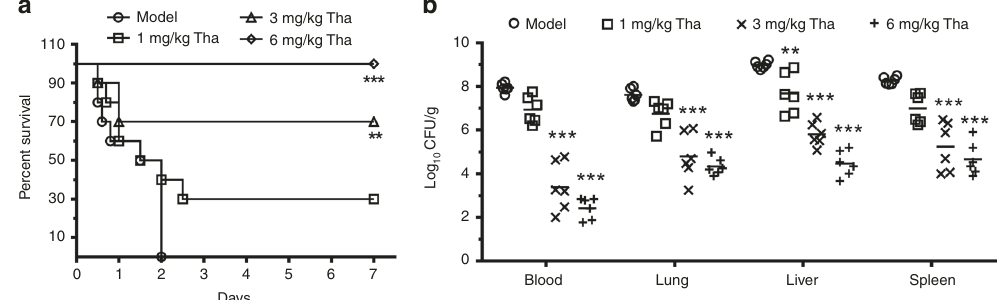
Fig. 4 Thanatin protects NDM-1-producing E. coli -infected mice. a Survival curves for the E. coli XJ141026 sepsis model. BALB/c mice were intraperitoneally administered with a lethal dose of E. coli XJ141026 and treated with three doses of thanatin via intraperitoneal injection ( n = 10 per group). b Bacterial loads in the blood, lungs, livers, and spleens of thanatin-treated E. coli XJ141026-infected mice were determined 24 h after infection ( n = 6 per group). P -values were determined by log-rank test ( a ) or one-way ANOVA with post-Bonferroni ’ s comparison test ( b ). ** P < 0.01, *** P < 0.001 vs. model. Source data